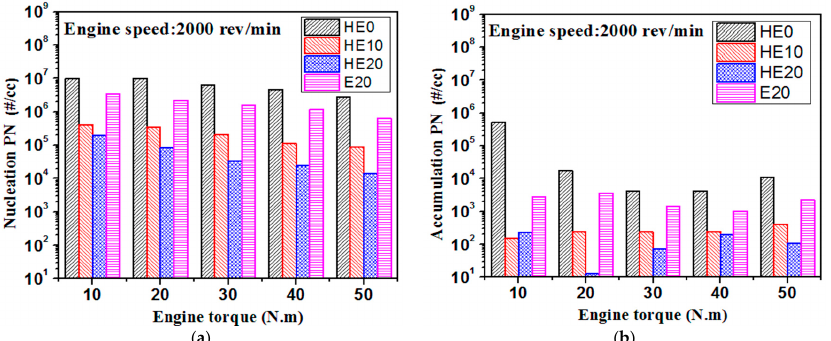
Figure 6. Variation of ( a ) nucleation mode; ( b ) accumulation mode number particles with engine load.